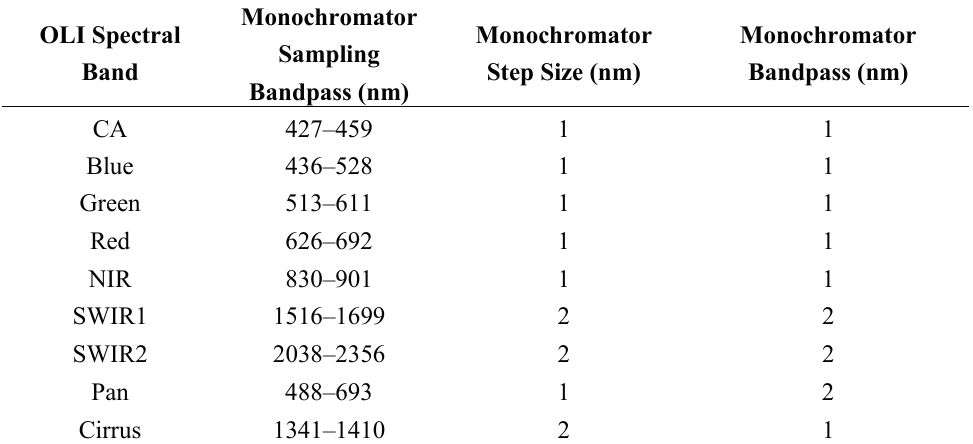
Table 3. Sampling specifications during pre-launch spectral testing of OLI.